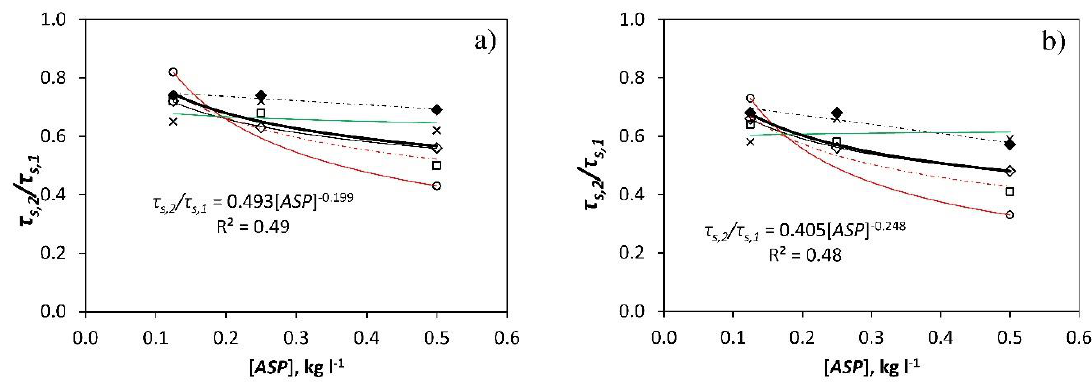
Figure 4. Mean values of the ratio τ s,2 / τ s,1 between 10:00 and 19:00 ( a ) and between 12:00 and 16:00 ( b ) according to the dose [kg l – 1 ] of the four ASP tested: ◊ (―), ASP BE (summer); ♦ ( ̵ · ̵ ), ASP BE (autumn);